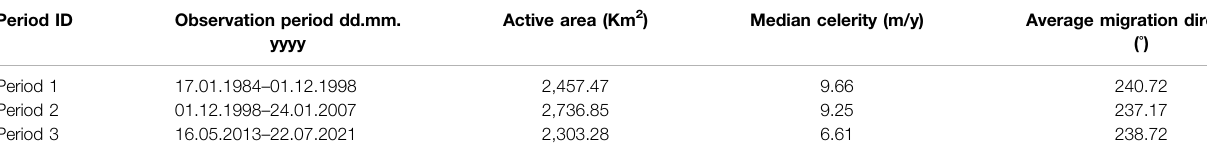
TABLE 1 | Dune migration rates and average migration direction over three observation periods.